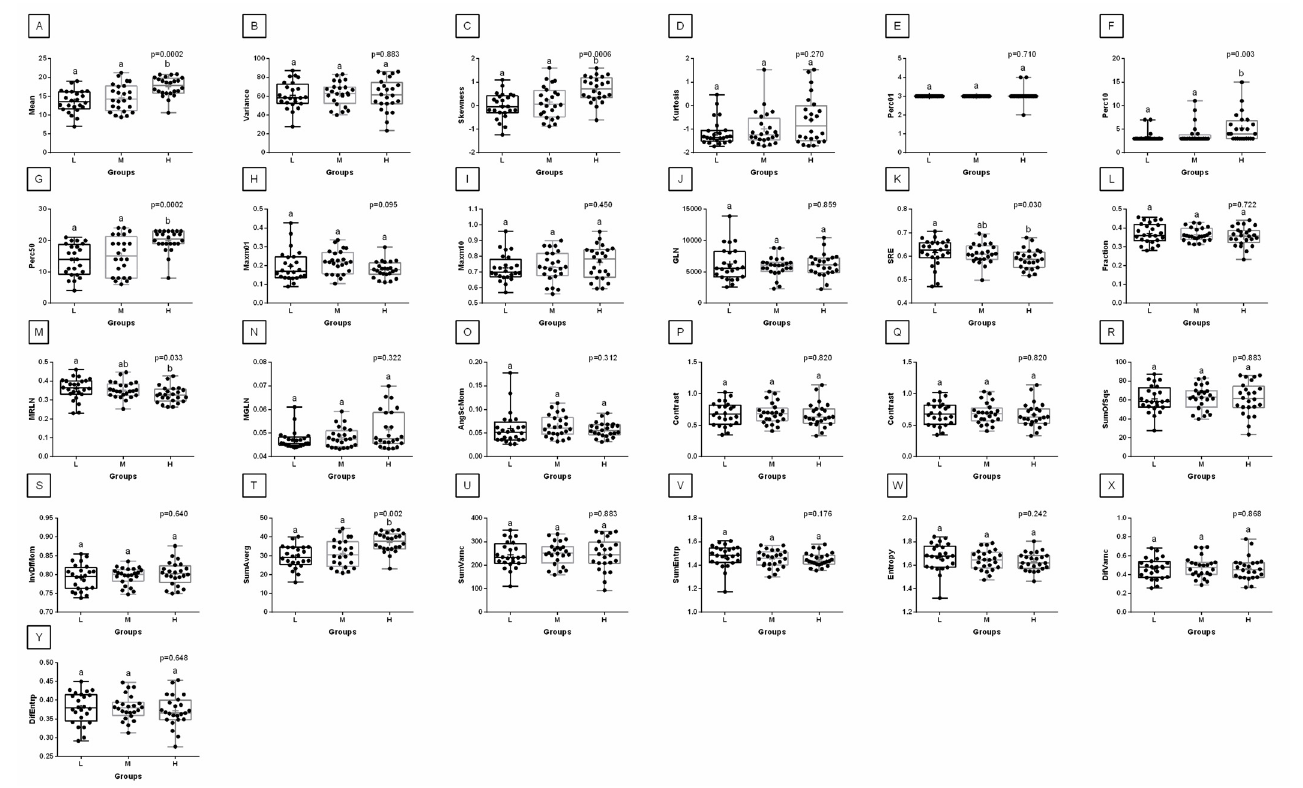
Figure 6. Analysis of texture features for the green component compared between light (L), moderate (M), and heavy (H) groups in the first region of interest (ROI 1). Differences between groups were indicated with individual p -values when p < 0.05. Different superscripts on each plot were statistically different. ( A ) Mean; ( B ) Variance; ( C ) Skewness—skewness coefficient; ( D ) Kurtosis; ( E – G ) Perc01, Perc10, Perc50—percentiles; ( H , I ) Maxm01, Maxm10—maximum of moments; ( J ) GLN— gray level non-uniformity; ( K ) SRE—short-run emphasis; ( L ) Fraction—a fraction of image in runs; ( M ) MRLN—run-length nonuniformity moment; ( N ) MGLN—gray level non-uniformity moment; ( O ) AngScMom—angular second moment/energy; ( P ) Contrast; ( Q ) Correlate; ( R ) SumOfSqs—sum of squares; ( S ) InvDefMom—inverse different moment/homogeneity; ( T ) SumAverg—summation mean; ( U ) SumVarnc—summation variance; ( V ) SumEntrp—summation entropy; ( W ) Entropy; ( X ) DifVarnc—differential variance; ( Y ) DifEntrp—differential entropy. Data are presented using minimum and maximum values, lower and upper quartiles, and median. The mean value is marked by a